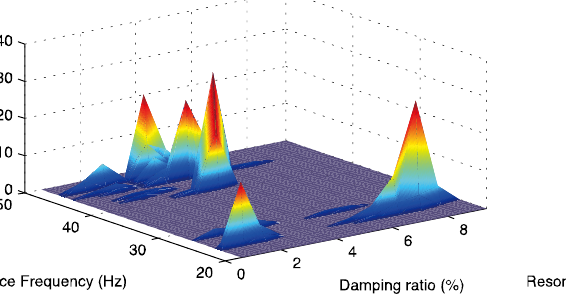
Fig. 16. Clusters of estimated poles from FRFs. Fig. 17. Clusters of estimated poles from Transmissibilities.